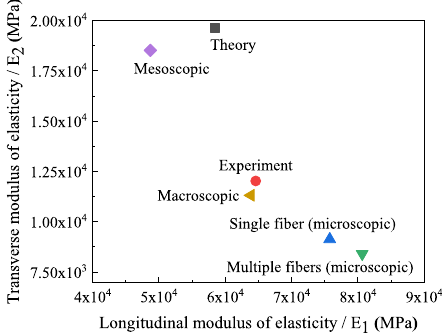
Figure 19. Elastic moduli at all scales, theoretical and